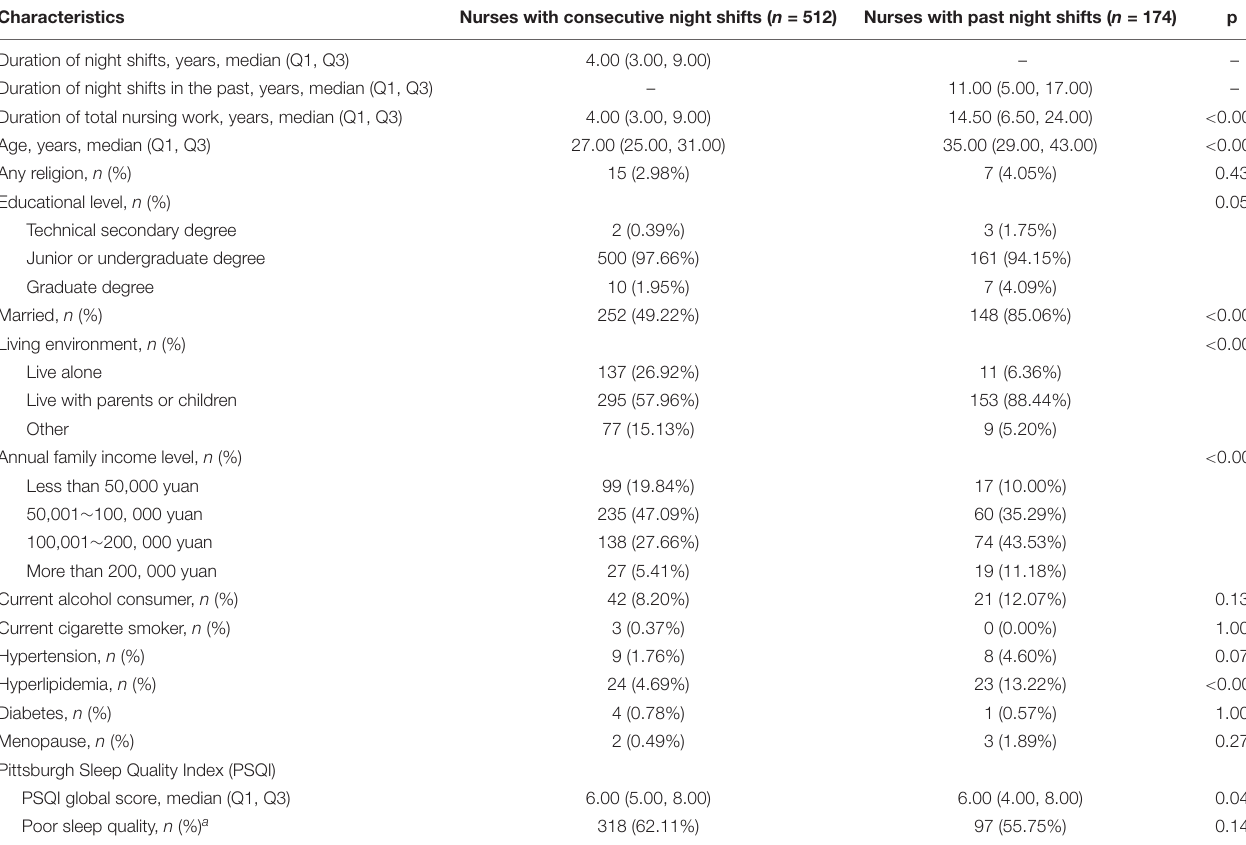
TABLE 1 | Basic characteristics of nurses working consecutive night shifts and nurses having worked past night shifts. Characteristics Nurses with consecutive night shifts ( n = 512) Nurses with past night shifts ( n =